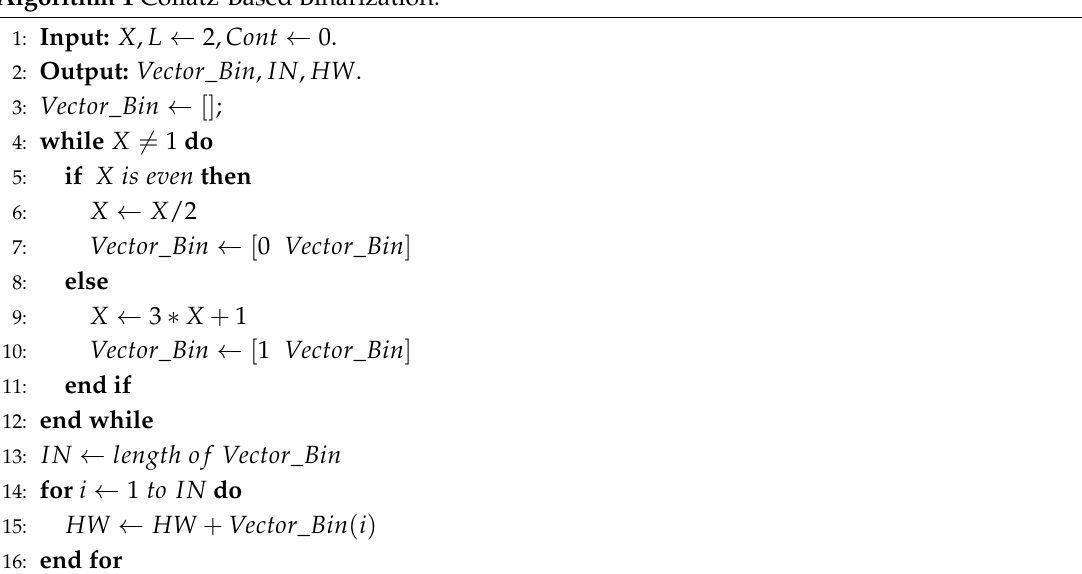
Algorithm 1 Collatz-Based